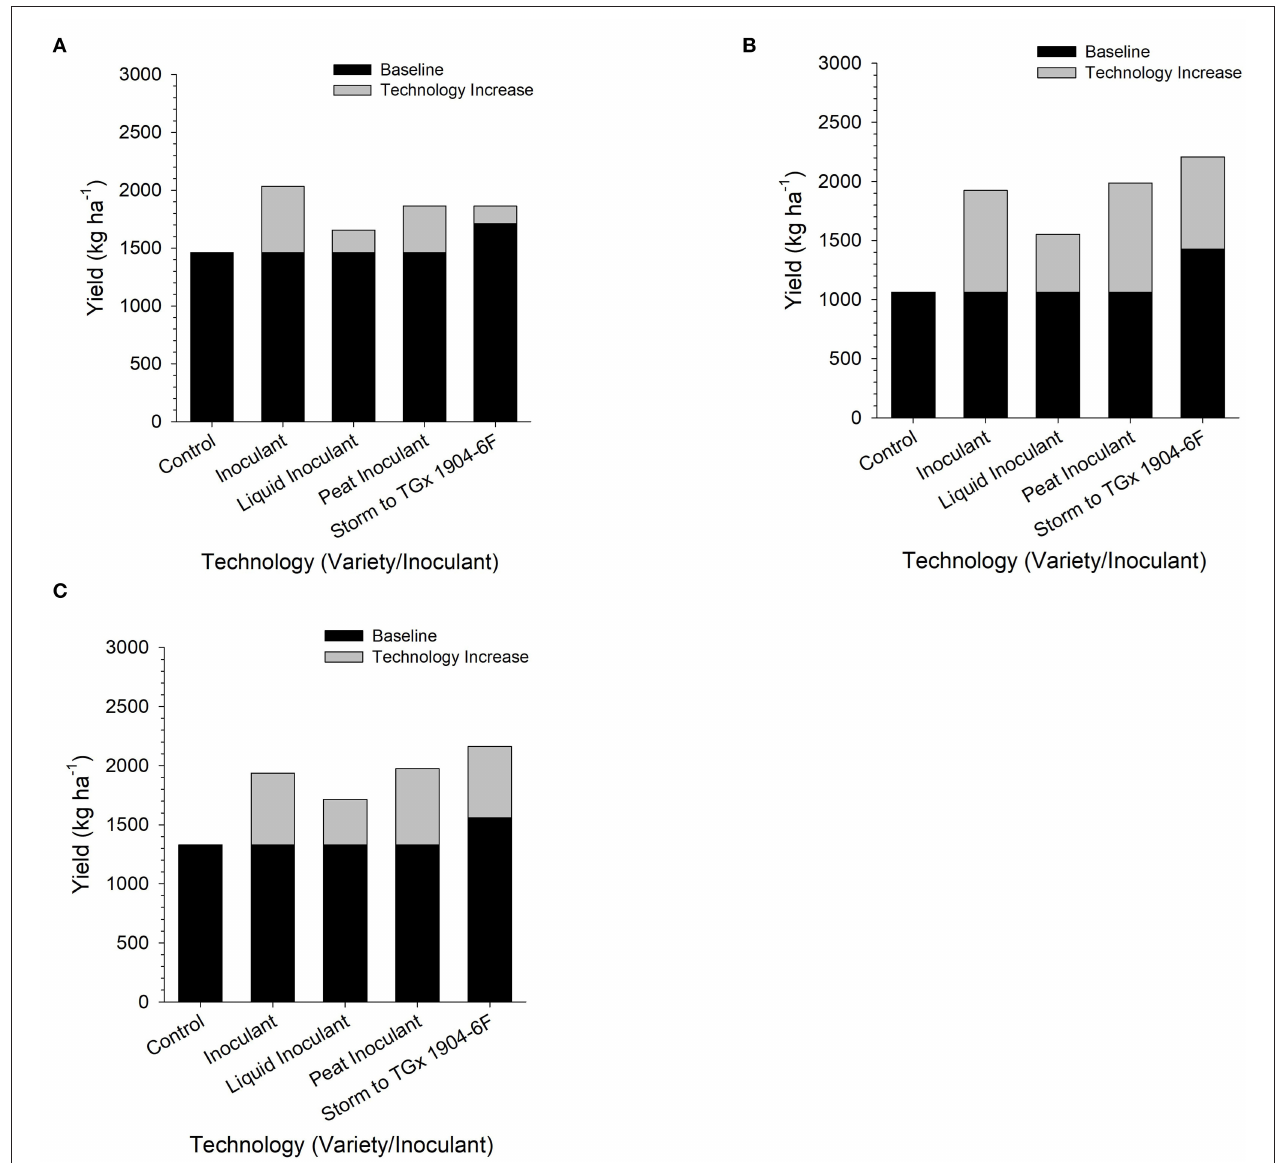
FIGURE 6 | Yield gain upon application of inoculants in Angonia (A) , Nampula (B) , and Ruace (C) across two growing seasons in 2016 and